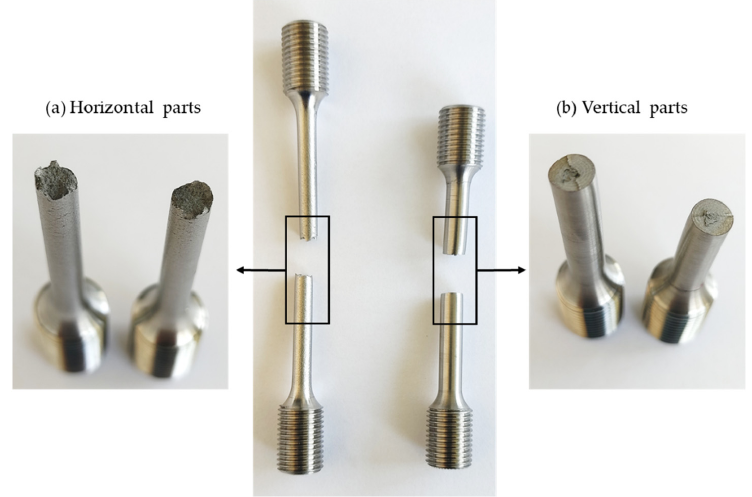
Figure 13. Fracture surface appearance: ( a ) horizontal parts; ( b ) vertical parts.